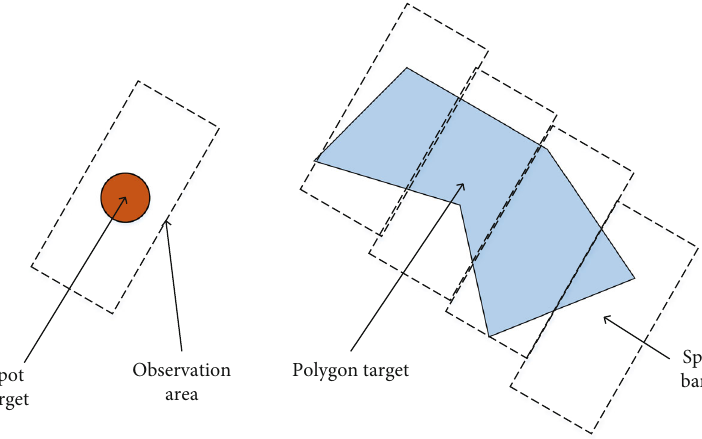
Figure 5: Schematic diagram of spot target and polygon